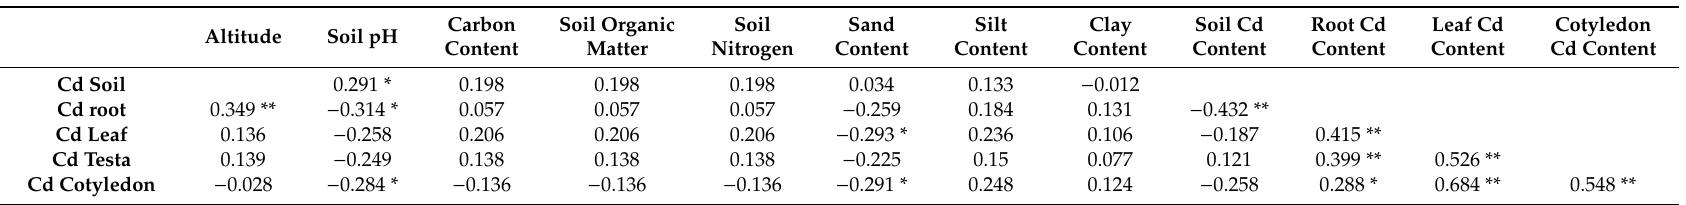
Table 1. Correlation coe ffi cients (r) between Cd content in soil and plant samples and top soil properties, including farm altitudes. (* p ≤ 0.05; ** p ≤